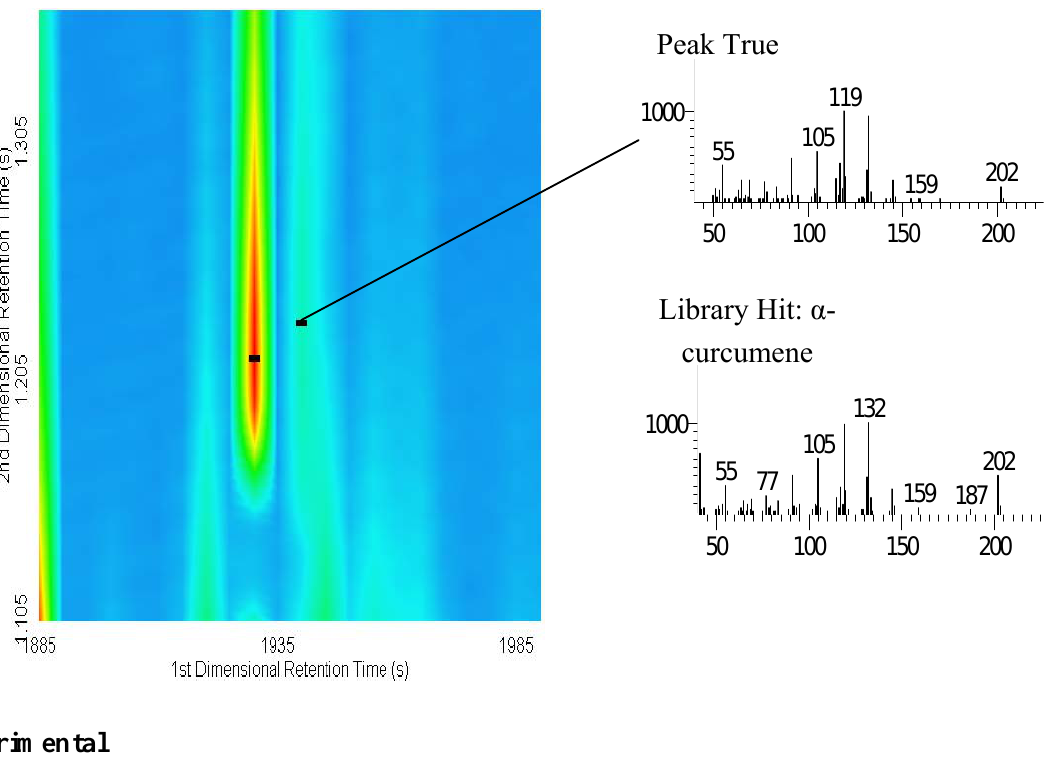
Figure 2. Details of the GC×GC contour plot chromatogram of α -curcumene, peak spectra of the sample, and peak spectra reported in the NIST